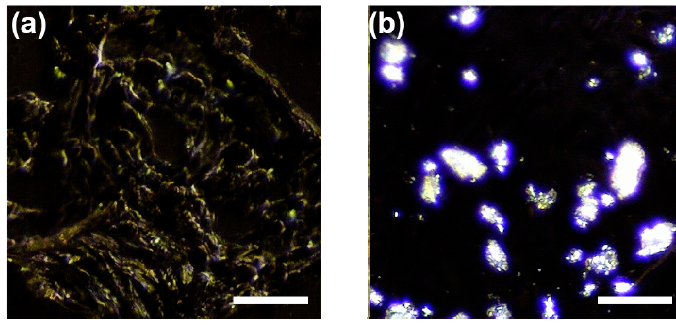
Figure 2. Polarization microscopy (PM) images of controlled samples. ( a ) collagen tissue from pig skin and ( b ) cholesterol crystal. Scale bars: 50 μ